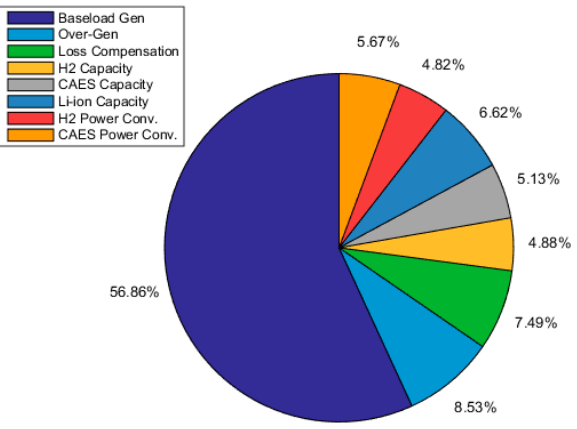
Figure 20. Breakdown of the total cost of electricity (75.62 £/MWh) achieved by the optimum system configuration.